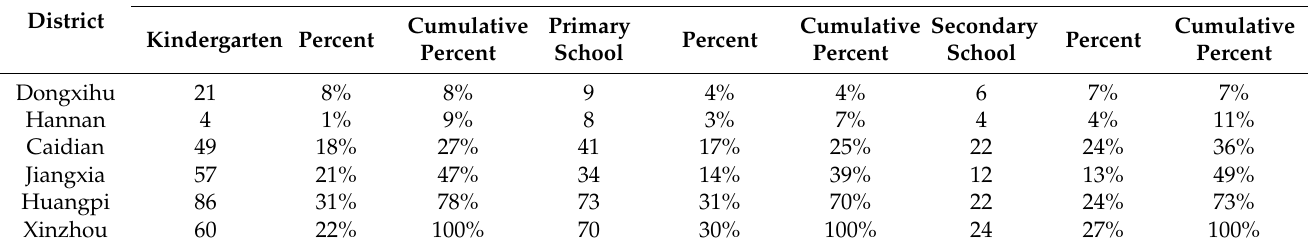
Table 3. The quantity distribution of rural basic educational resources in Wuhan City’s new urban